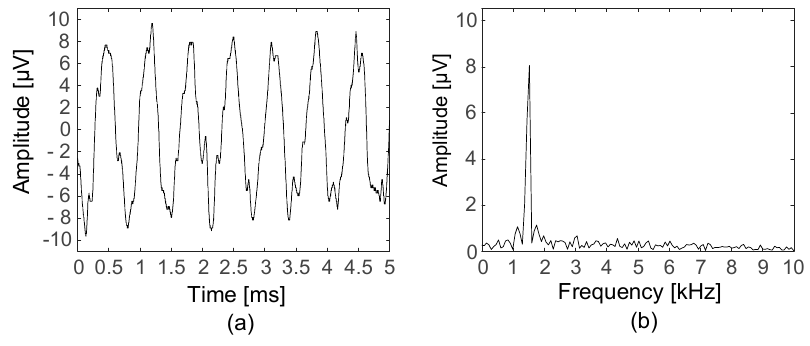
Figure 10. Measured output signal: ( a ) in the time domain and ( b ) in the frequency domain.